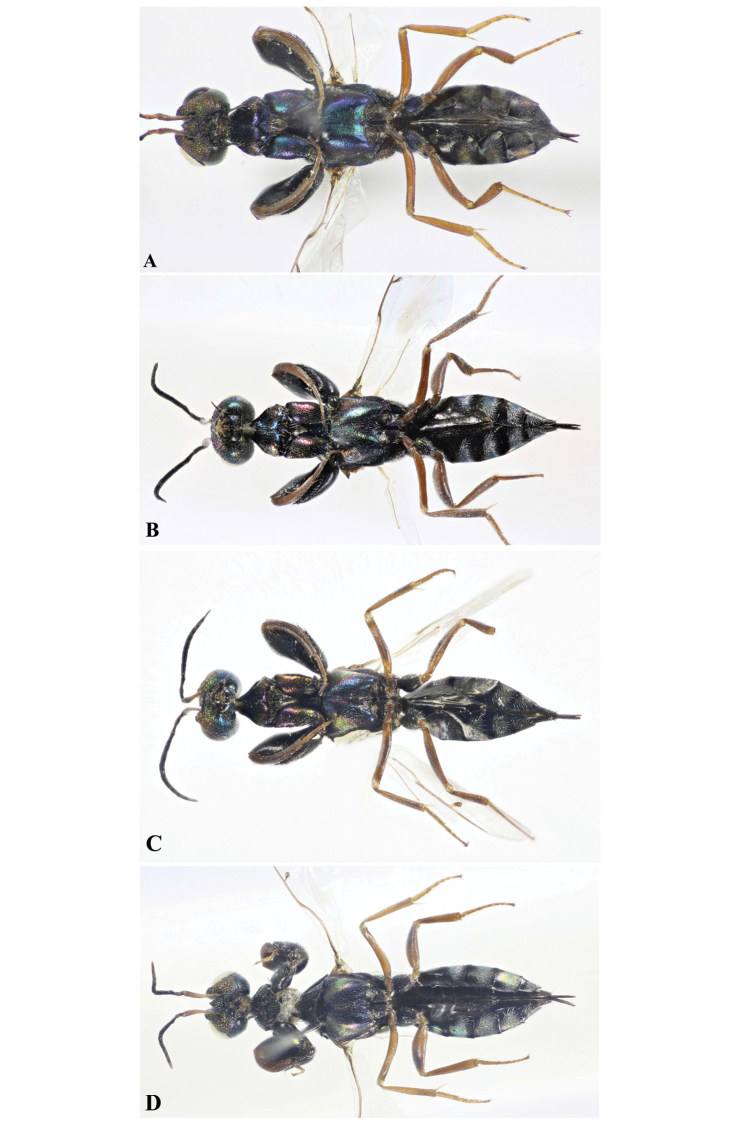
Ventral habitus, Holotype AOodera
arabica sp. nov. BOodera
omanensis sp. nov. COodera
rapuzzii sp. nov. DOodera
similis sp. nov.